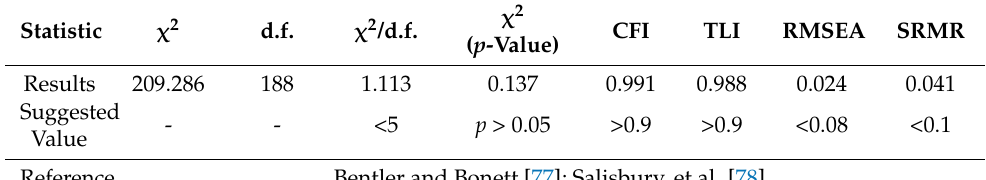
Table 2. Model fit for